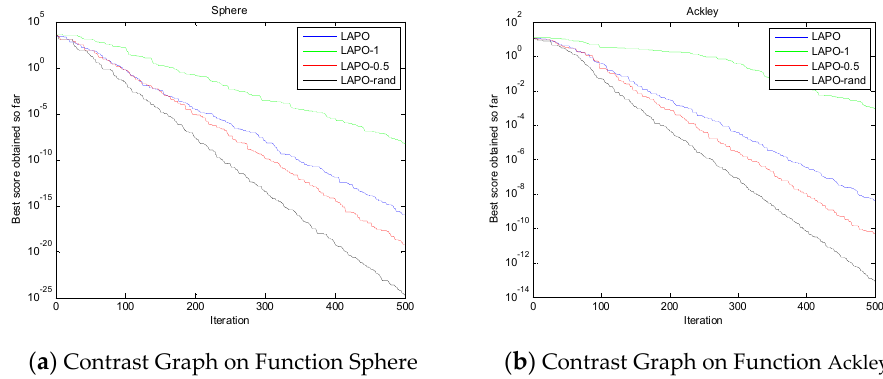
Figure 3. The comparison of LAPO and LAPO combined with opposition-based learning (OBL).